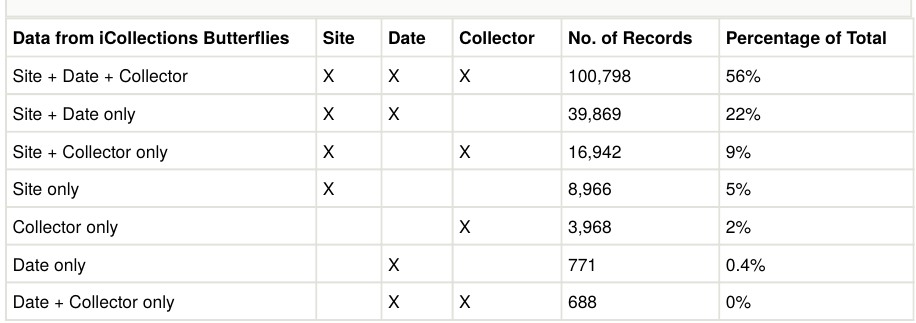
Data available after